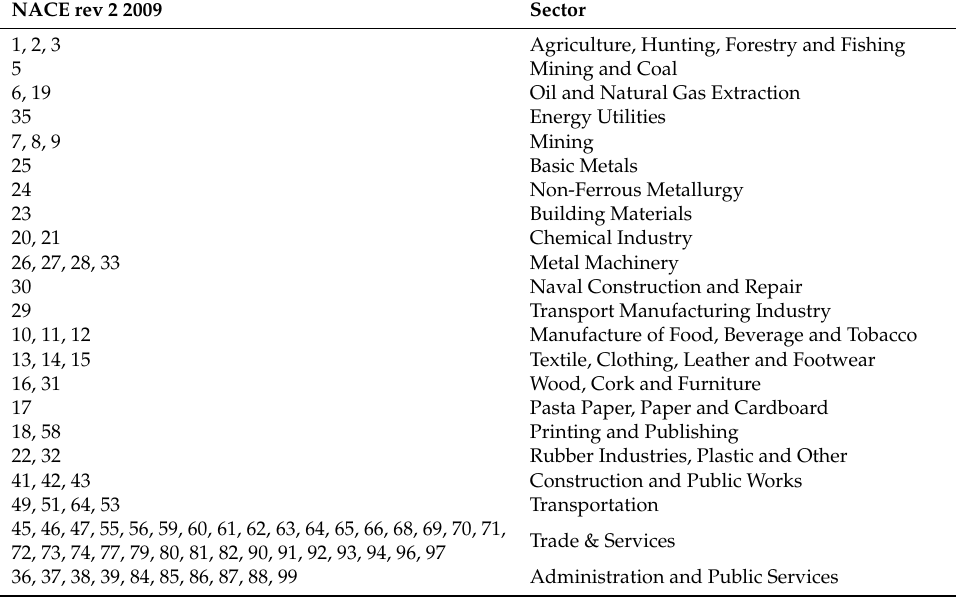
Table A2. Sectorial definition and NACE